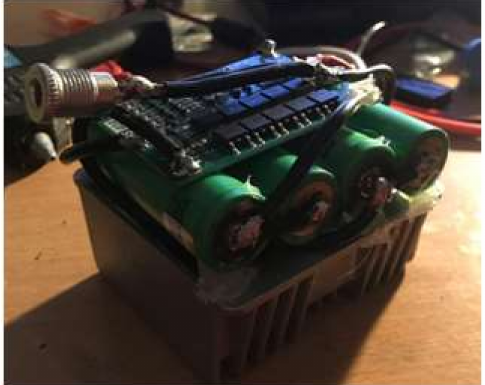
Figure 8. Designed and assembled 16.7 V battery with a peak current of 30 A for autonomous power supply of the prototype.